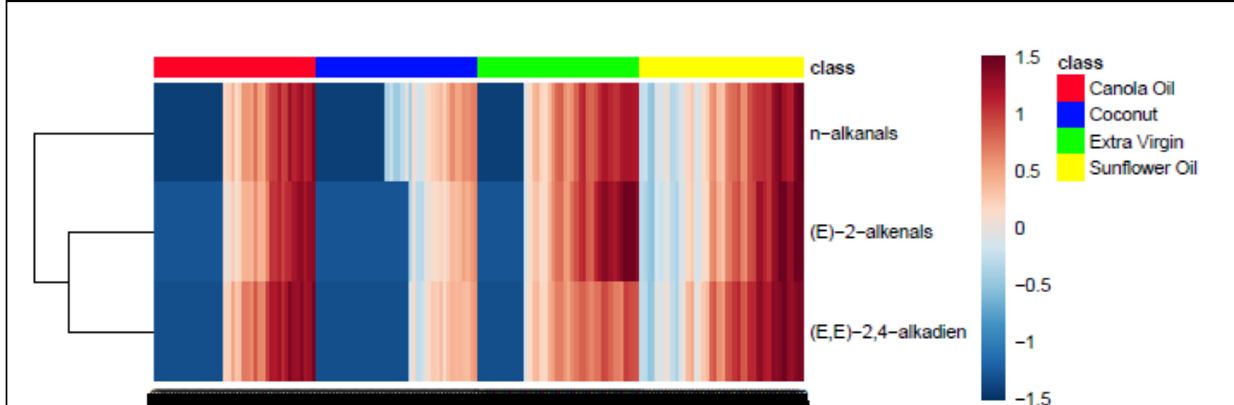
Figure 3. AHC monoclustering heatmap diagram displaying, from left to right, increasing concentrations of the three major aldehydic LOPs ( n -alkanals, trans -2-alkenals and alka- trans,trans -2,4-dienals) as a function of LSSFE time-point for canola (red), coconut (blue), extra-virgin (green) and sunflower oils (yellow); there were n = 6 replicate samples analysed per time-point. The dataset was glog-transformed and autoscaled prior to analysis. Transformed aldehyde concentrations are shown in the right-hand side y -axis: deep blue and red colourations represent extremes of low and high levels, respectively. The left-hand side of the plot shows results arising from a preliminary AHC analysis of these aldehydic LOP variables monitored. Abbreviation: ( E,E )-2,4-alkadien represents alka-( trans,trans )-2,4-dienals.